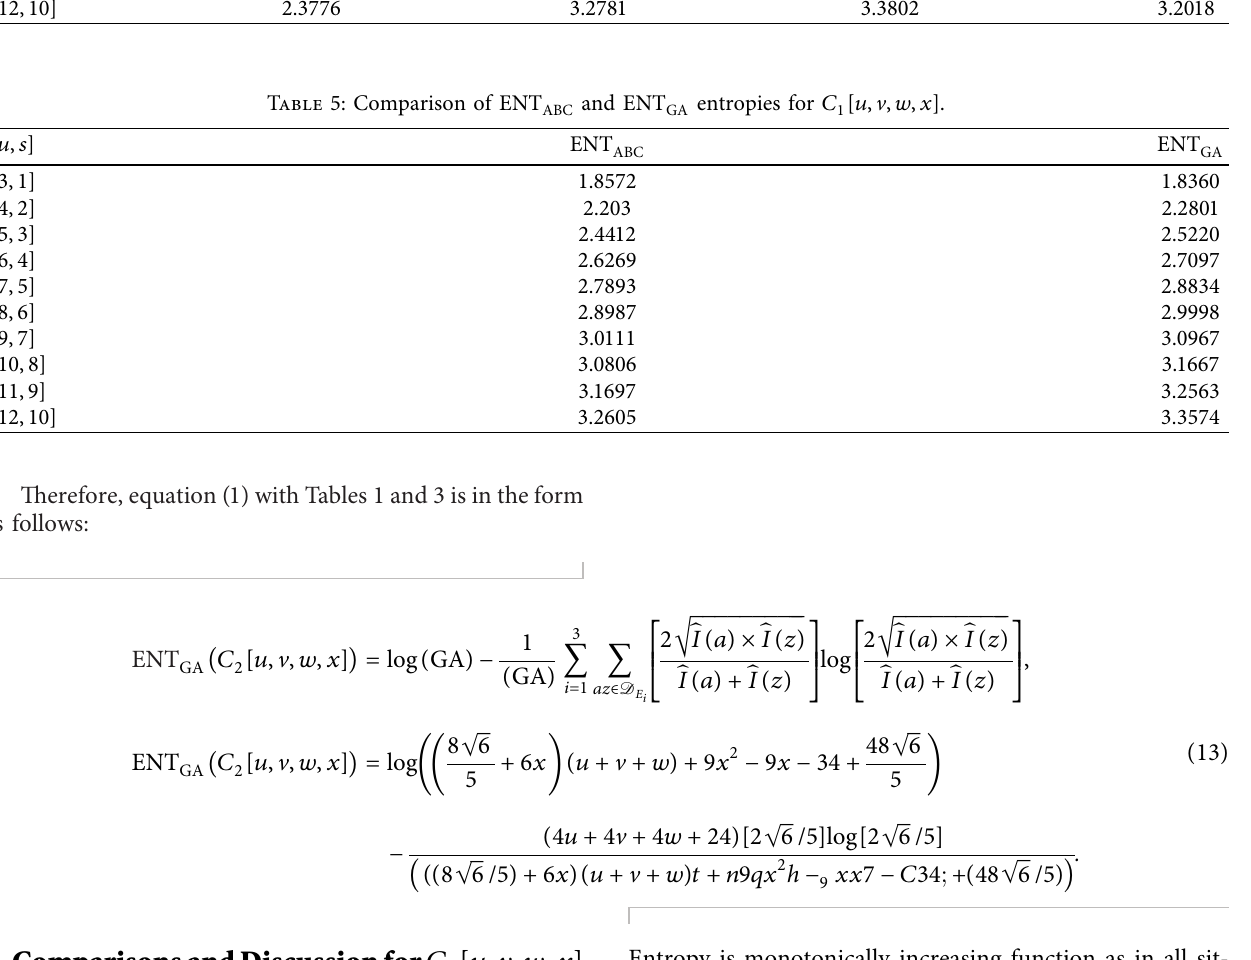
Table 4: Comparison of Randic entropies for C